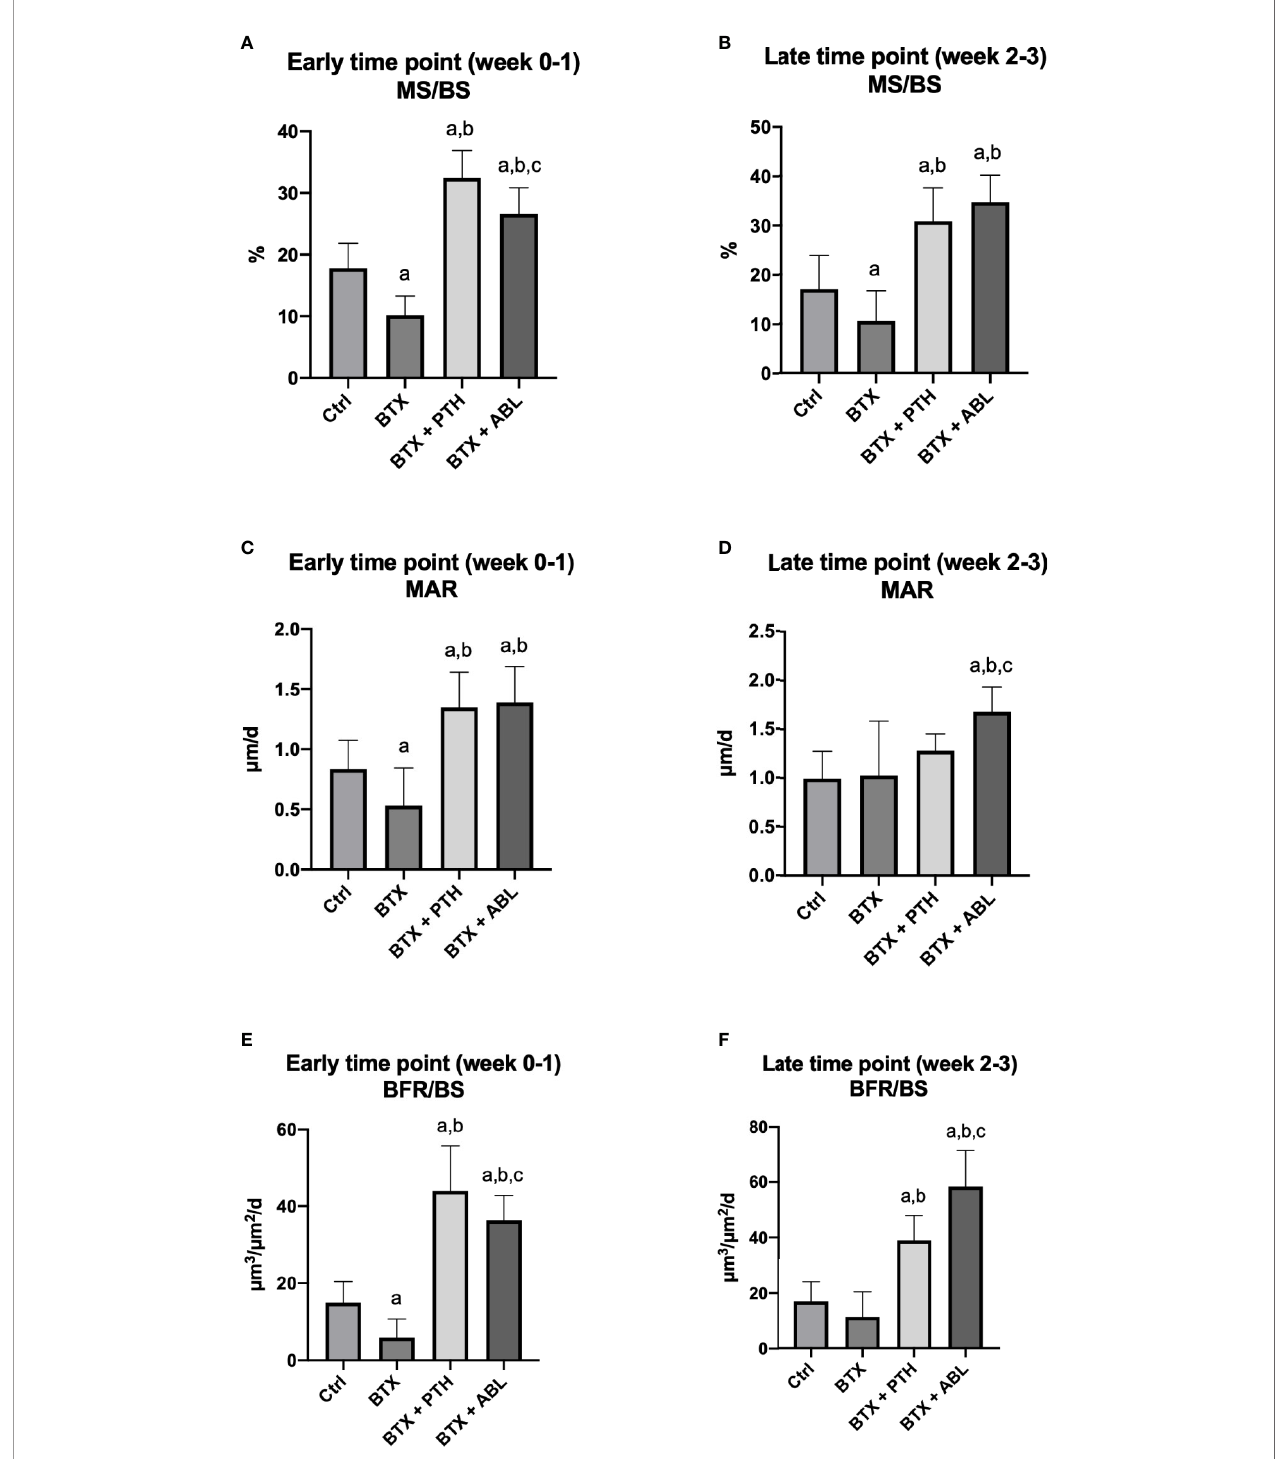
FIGURE 8 | Dynamic bone histomorphometry on the proximal tibial metaphysis of rats with the right hindlimb immobilized with BTX and treated with PTH or ABL. (A, B) MS/BS, mineralizing surface; (C, D) MAR, mineral apposition rate; (E, F) BFR/BS, bone formation rate. Data are presented as mean ± SD. a: p < 0.05 vs. Ctrl. b: p < 0.05 vs. BTX. c: p < 0.05 vs. BTX +